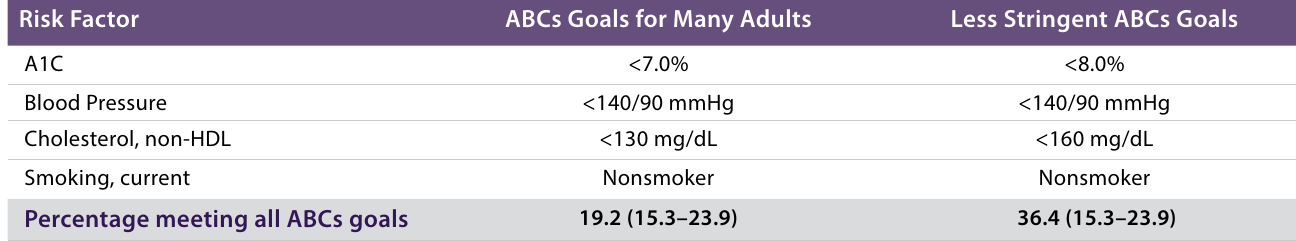
Table 4. Crude percentage of adults aged 18 years or older with diagnosed diabetes meeting all ABCs goals, United States,